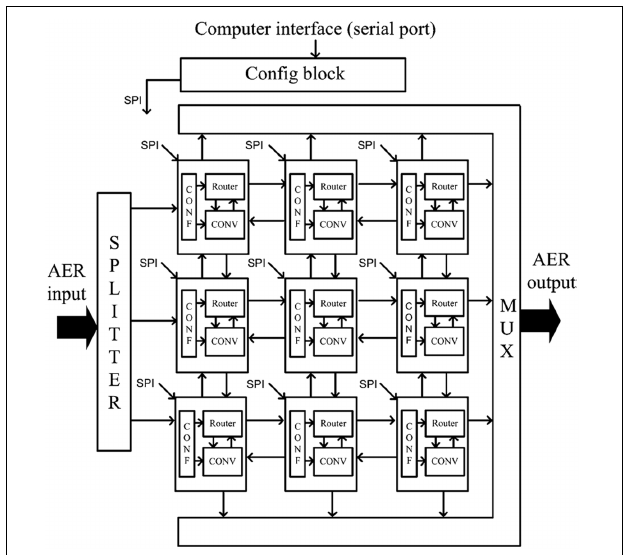
FIGURE 9 | Measurement of the disparity (distance) between a pixel in Retina 1 and its corresponding epipolar line in Retina 2. The minimum disparity point separates Region A and B.